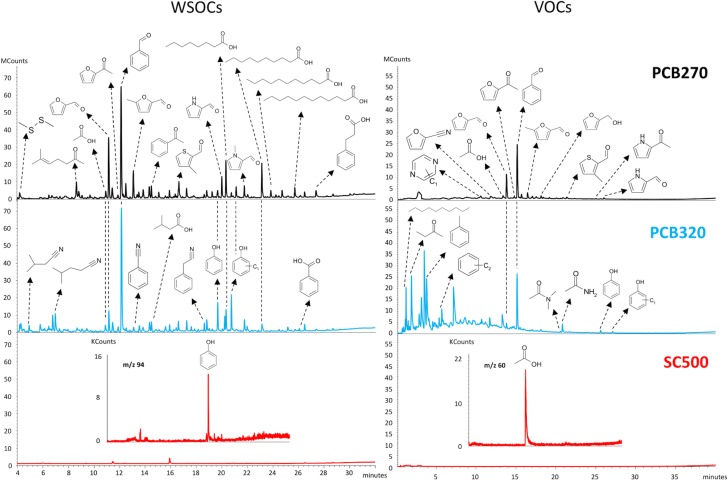
Total ion chromatograms of water-soluble (WSOCs, left) and volatile organic compounds (VOCs released at 25°C, right) in PC biosolids produced at 270°C (PCB270), 320°C (PCB320) and softwood biochar produced at 500°C (SC500).Note the same Y-scale was used for VOCs and WSOCs. The diversity and abundance of VOCs and WSOCs were altered by the production temperature for PC biosolids. The intensities for biochar (SC500) were more than one order of magnitude lower compared to PC biosolids and compounds were detected by mass chromatograms of ions characteristics of specific compounds (inset for SC500).